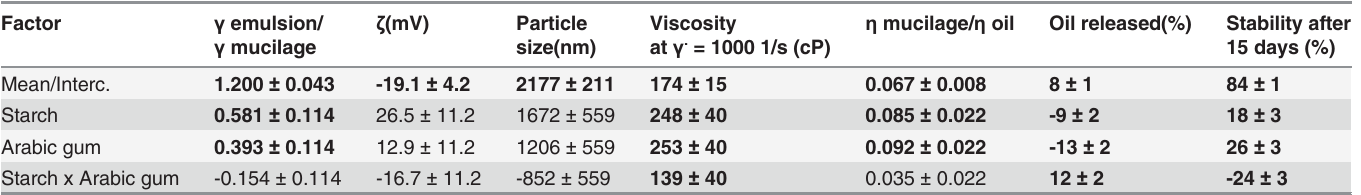
Table 5. Effect ( ± standard error) of the independent variables on the ratio between the surface tension of the emulsion and of the mucilage ( γ emulsion/ γ mucilage), ζ , particle size, viscosity, ratio between the viscosity of the mucilage and of the oil+SAIB ( η mucilage/ η oil), amount of oil released and stability of the emulsion after 15 days, in the full-factorial experimental design. η mucilage/ η oil Oil released(%) Stability after ζ (mV) Particle Factor γ emulsion/ Viscosity γ mucilage 15 days (%) size(nm) at γ . = 1000 1/s (cP) Mean/Interc. 1.200 ± 0.043 84 ± 1 Starch 0.581 ± 0.114 18 ± 3 Arabic gum 0.393 ± 0.114 26 ± 3 Starch x Arabic gum -0.154 ± 0.114 -16.7 ± 11.2 -24 ±